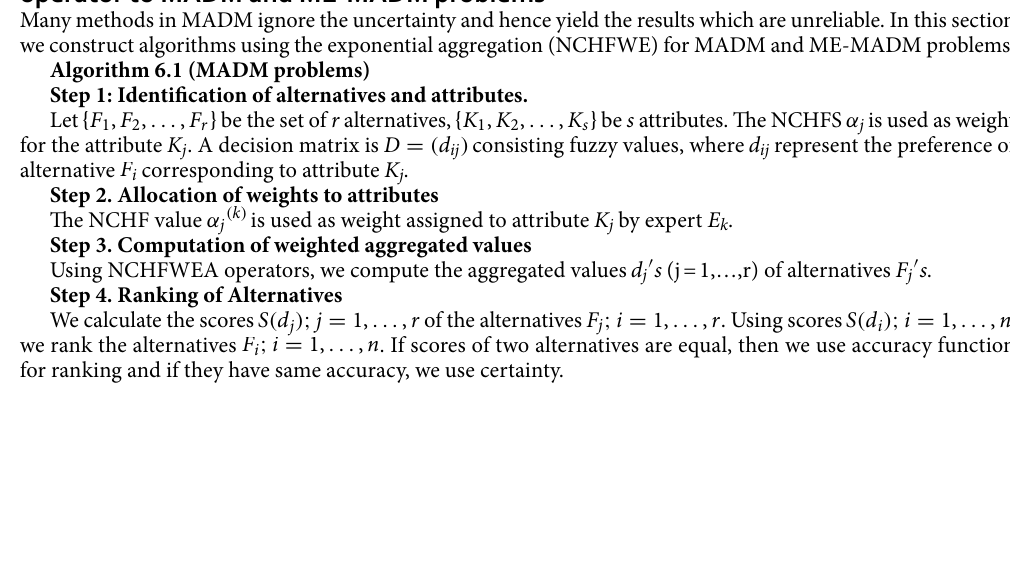
Algorithm 6.1 (MADM problems) Step 1: Identification of alternatives and